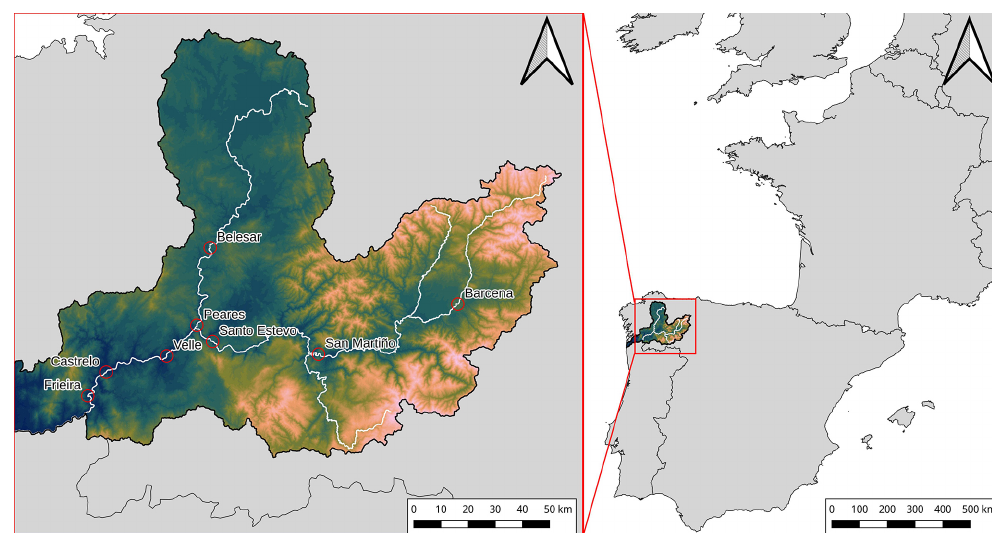
Figure 1. Location of the reservoirs analyzed in this study.